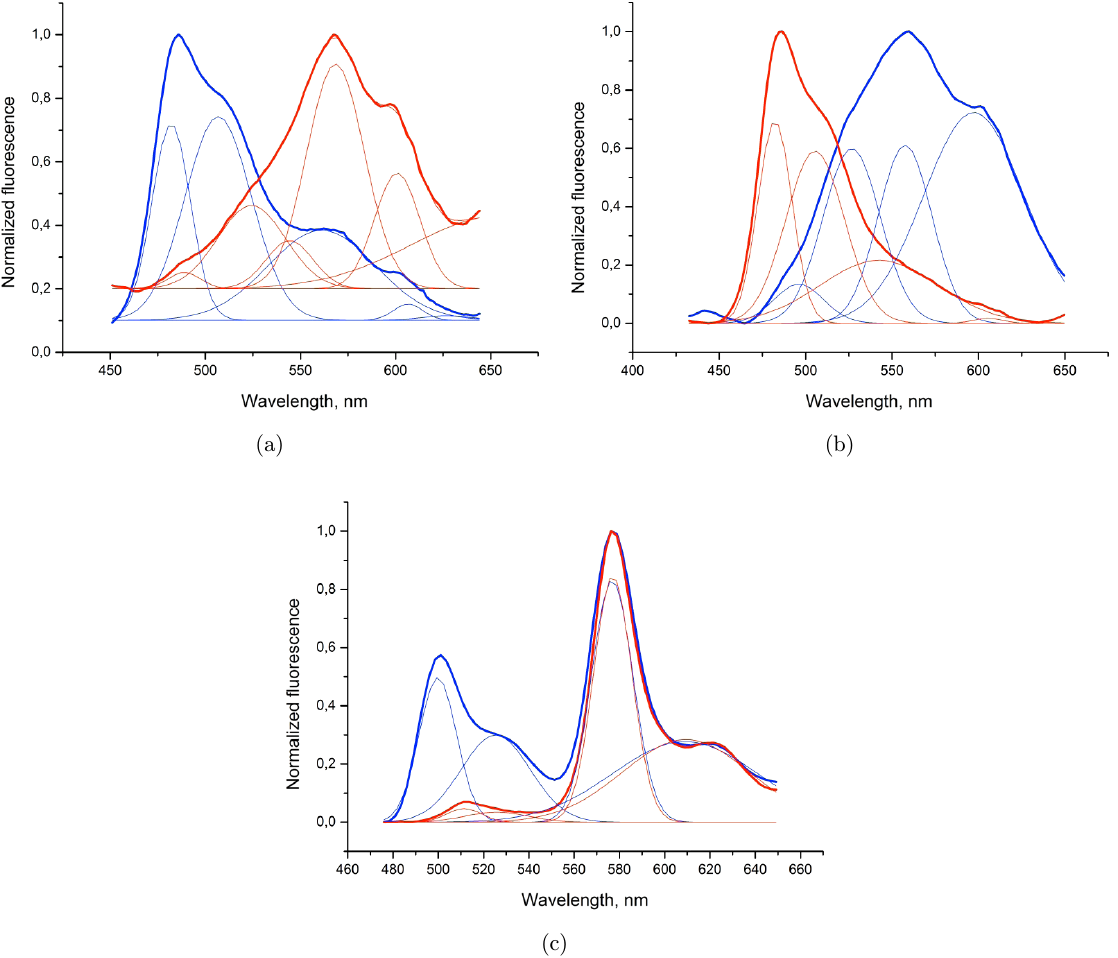
Fig. 2. Fluorescence spectra of A. digitifera (A), A. hyacinthus (B) E. aspera (C) from two di®erent parts of colonies. Spectra are shown with solid blue and red lines. Fluorescence curves were analyzed and their Gauss peaks shown (narrow solid lines colored as analyzed curves). A and B spectra obtained with Specral-Cluster and C with custom made spectrometer. Excitation is 380 nm (A and B) and 473 nm